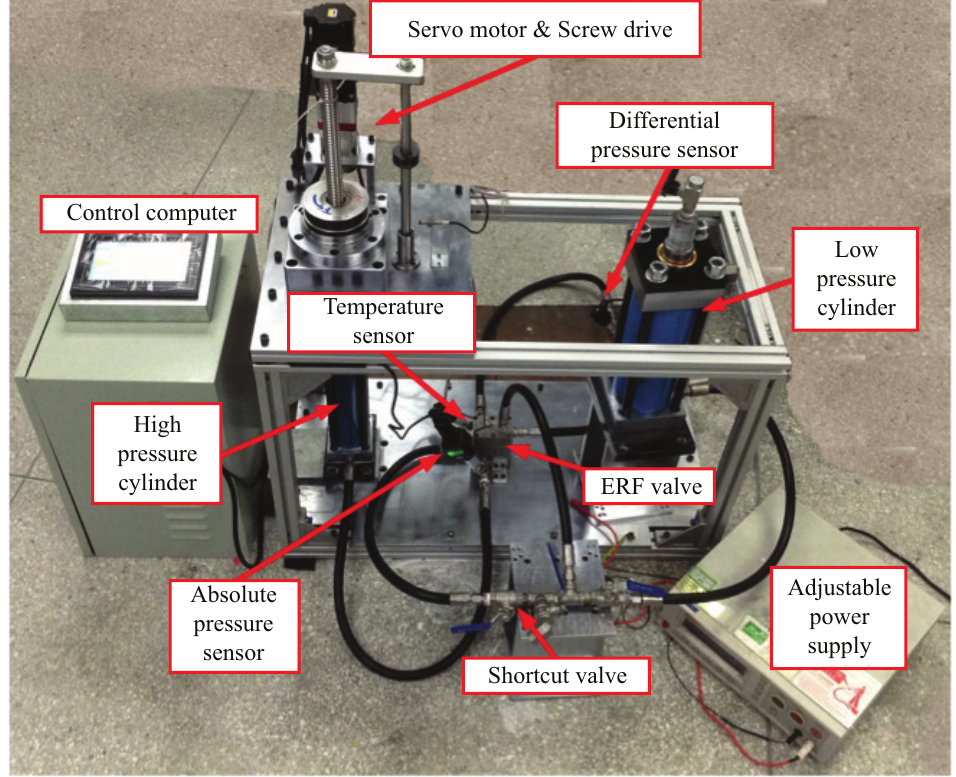
Figure 8. The complete ERF valve test-bed is shown.